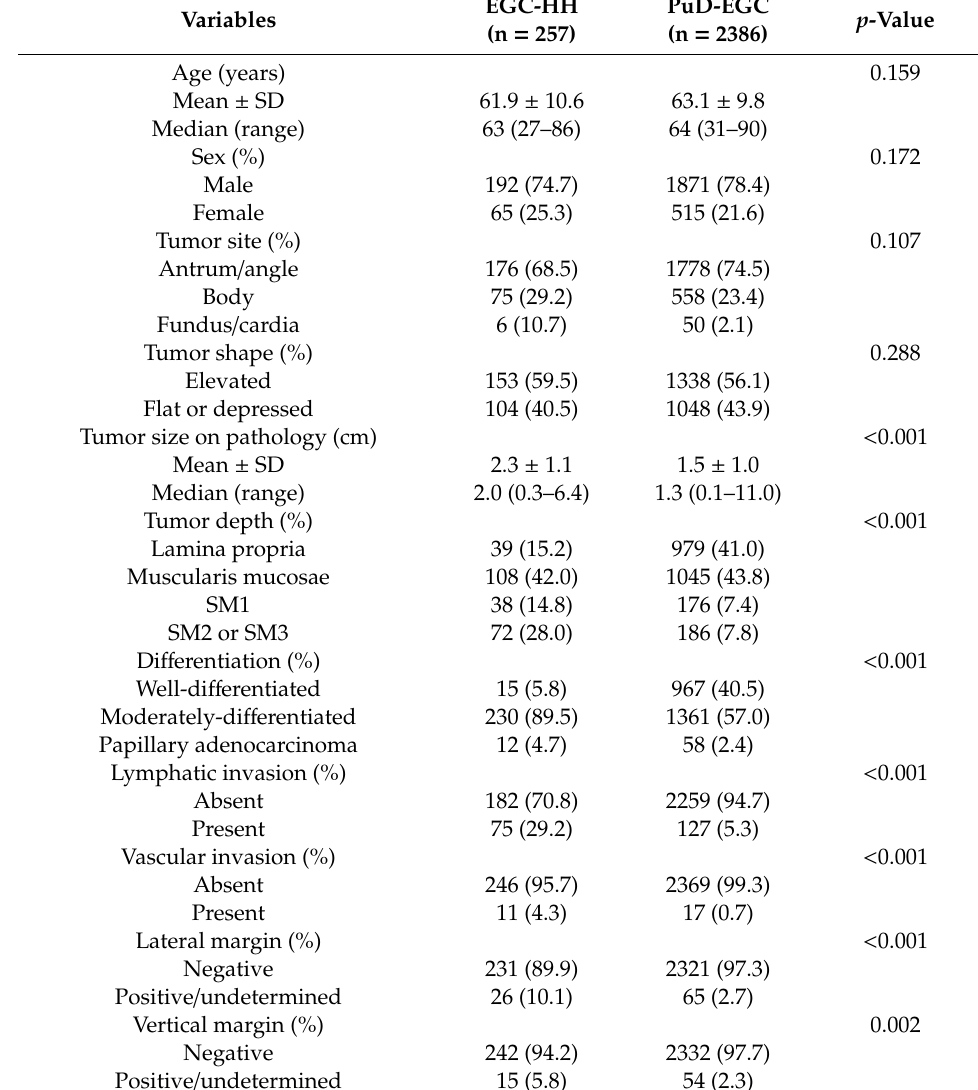
Table 1. Comparison of clinicopathologic characteristics of di ff erentiated-type early gastric cancers with and without histological